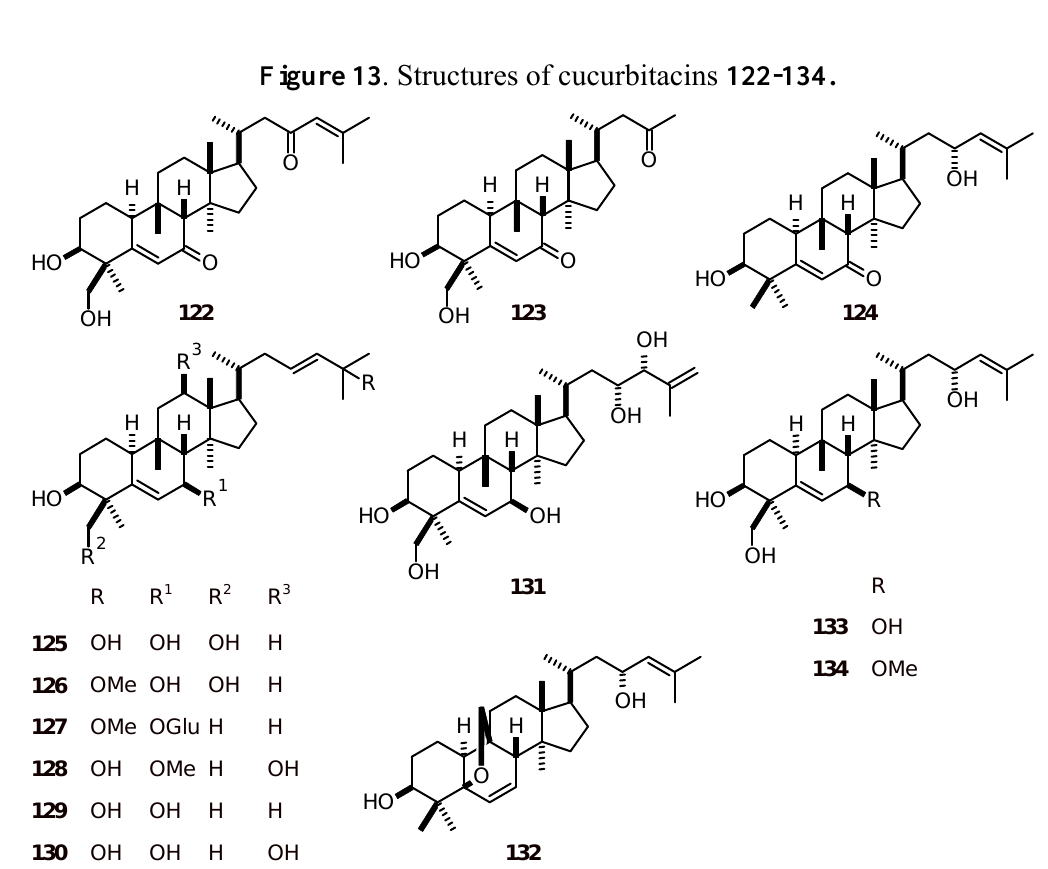
Figure 13 . Structures of cucurbitacins